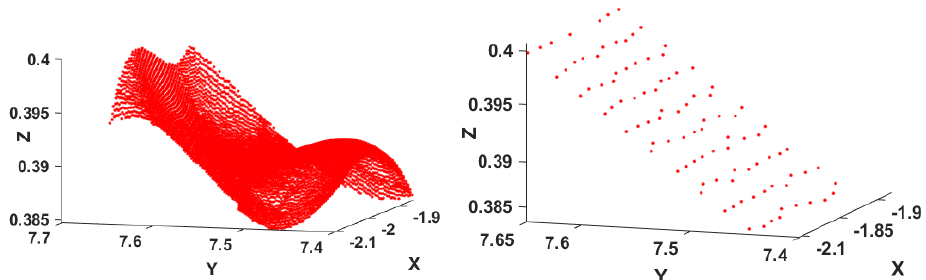
Figure 3. L13: Effect of the point cloud reduction by gridding the raw observations. Left : B-splines fitting without gridding. Right : Surface approximation with gridding, case (i).